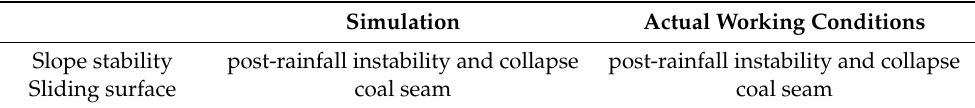
Table 7. Comparison between the MIDAS GTS simulation and the actual working conditions. Simulation Slope stability Sliding surface coal seam coal seam